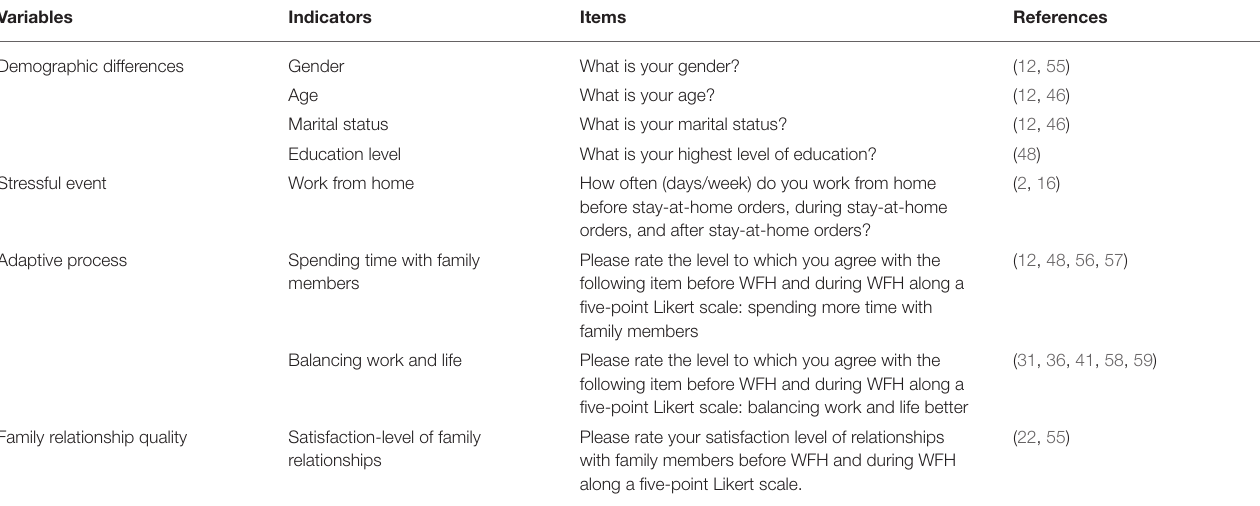
TABLE 1 | Variables examined in the study and items used to measure